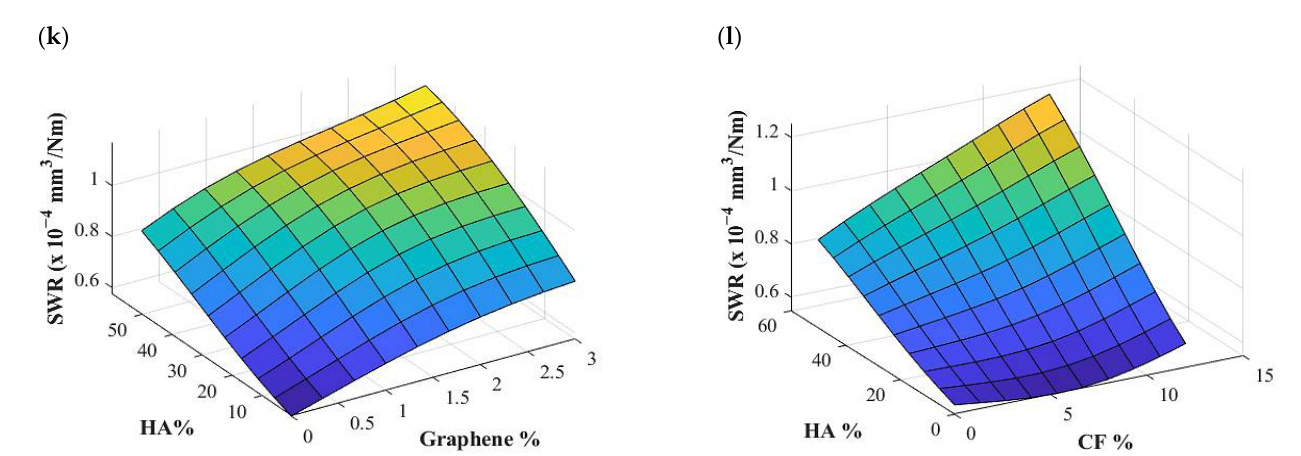
Figure 6. Surface plots showing the variation in ( a ) E with CNT–HA wt%, ( b ) E with graphene–HA wt%, ( c ) E with CF–HA%, ( d ) UTS with CNT–HA wt%, ( e ) UTS with graphene–HA wt%, ( f ) UTS with CF–HA%, ( g ) CoF with graphene–HA wt%, ( h ) CoF with CNT–HA wt%, ( i ) CoF with CF–HA%, ( j ) SWR with CNT–HA wt%, ( k ) SWR with graphene–HA wt%, and ( l ) SWR with CF–HA%.